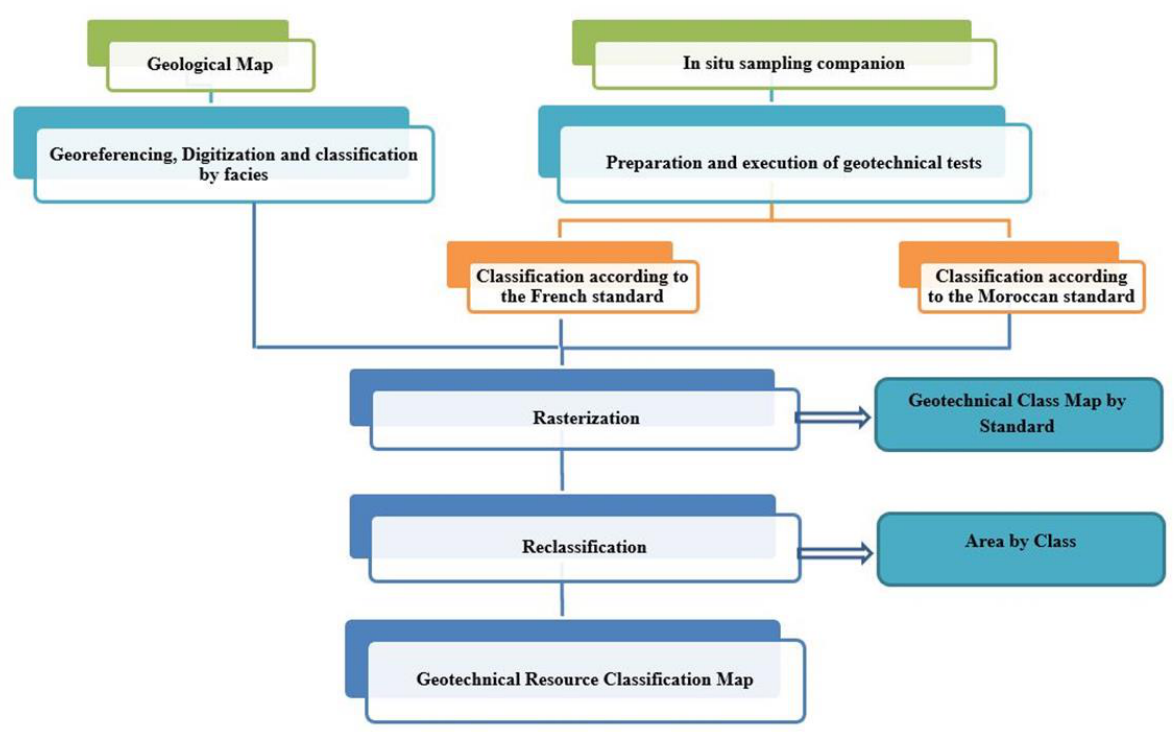
Figure 3. Conceptual diagram of the steps followed to produce the geotechnical resource map. Table 1. Geological formations of